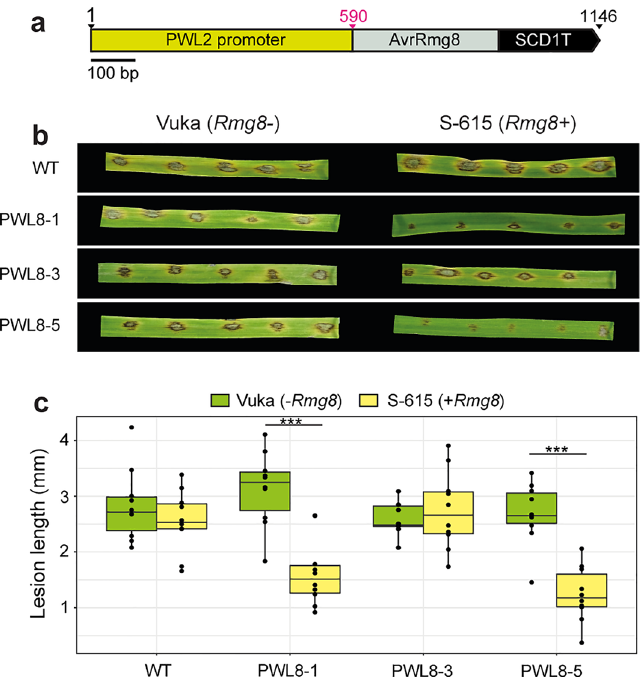
Figure 1. Introduction of AvrRmg8 into MoT strain N06047 under the PWL2 promoter induced a visible Rmg8 -mediated HR phenotype. ( a ) Schematic representation of the pCB-Ppwl2 - AvrRmg8 - stop vector used for transformation of MoT (strain N06047). Scale bar represents 100 bp. ( b , c ) Introduction of the PWL2p::AvrRmg8 transgene into MoT induced a visible Rmg8 -mediated hypersensitive response (HR), specifically restricting the growth of two of the three transformants obtained when inoculated onto the wheat line S-615 ( Rmg8 +). The second leaf of two-week old wheat seedings of the lines Vuka ( Rmg8- ) and S-615 ( Rmg8 +) were inoculated with conidial suspensions derived from three separate transformants (PWL8-1,3,5) using the spot inoculation method. Images were taken and lesion lengths measured at 4 days post-inoculation, with three biological replicates conducted (separate leaves). WT, wild-type (MoT strain N06047). Asterisks denote statistically significant differences (***: p < 0.001; 2-tailed t